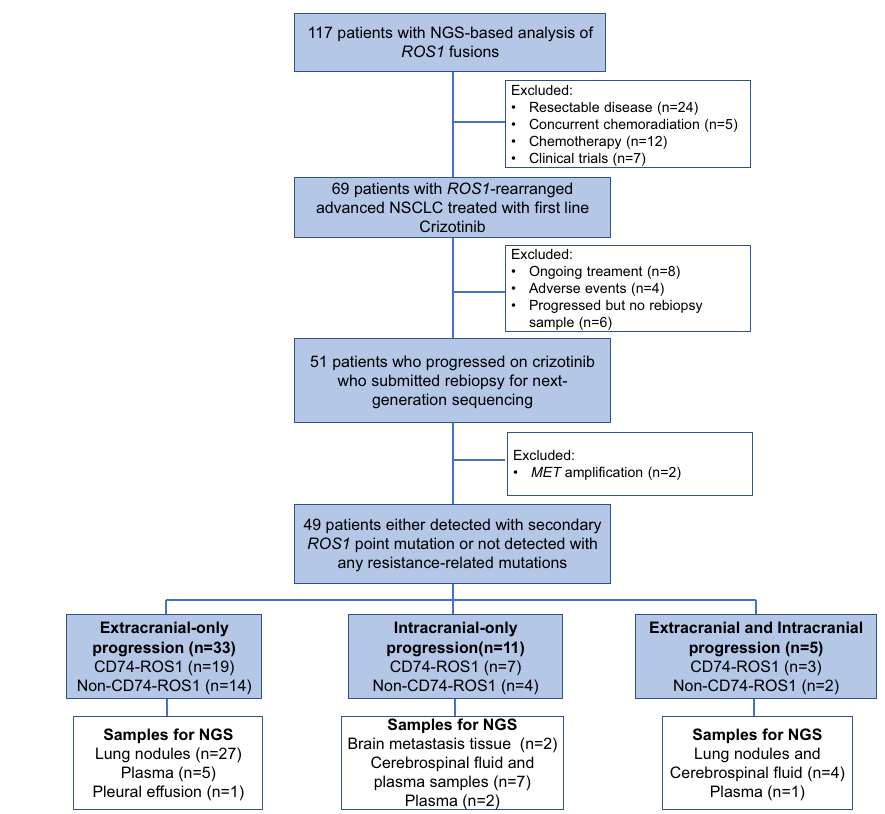
Fig. 1 Study pro fi le. Flow chart illustrating the study